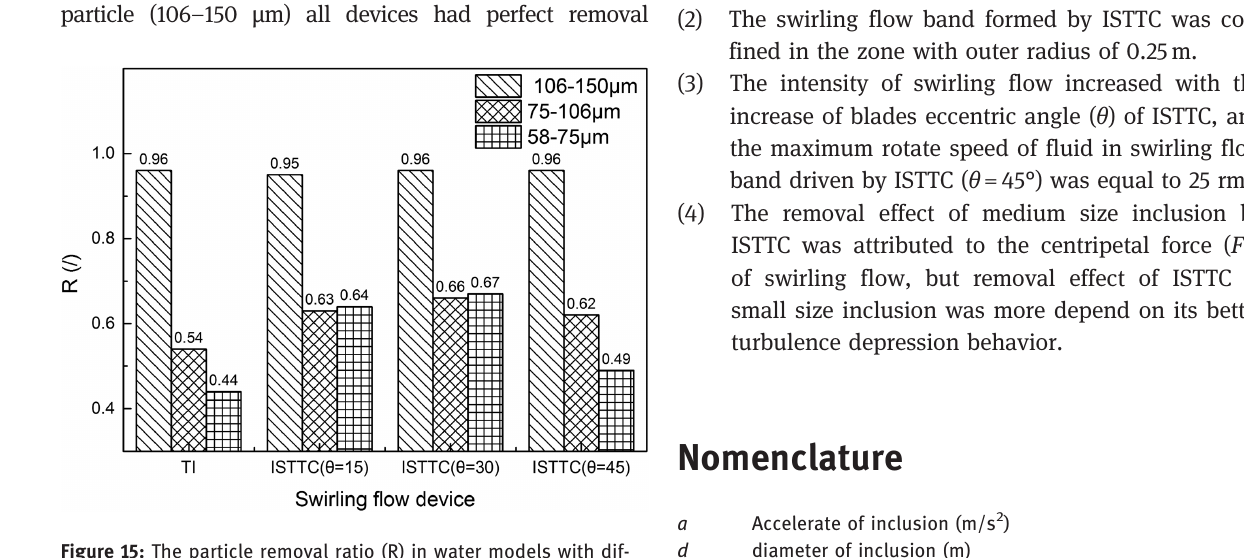
Figure 15: The particle removal ratio (R) in water models with dif- ferent swirling flow devices.